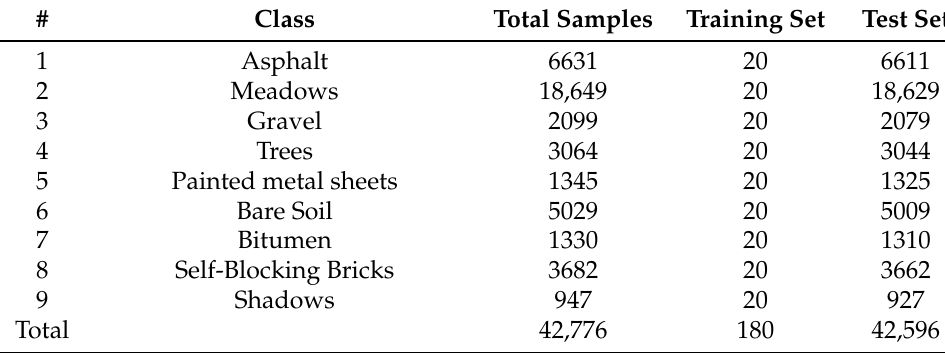
Table 3. The number of samples in each category in the PaviaU